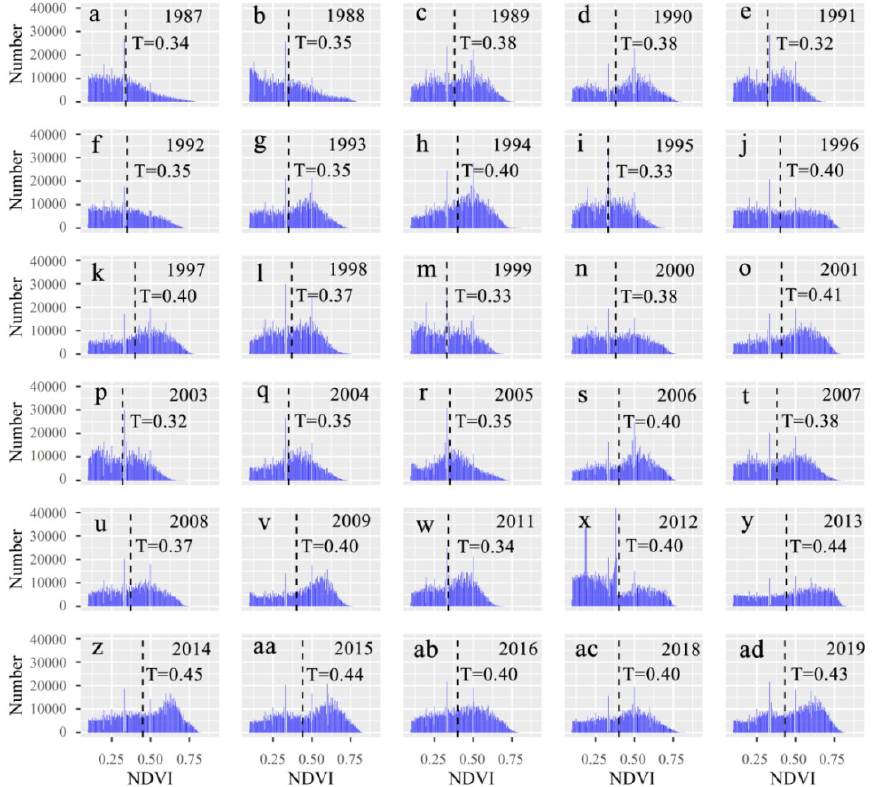
Figure 3. The annual Otsu NDVI threshold of Gongga Mountain from 1987–2019; ( a ) 1987; ( b ) 1988; ( c ) 1989; ( d ) 1990; ( e ) 1991; ( f ) 1992; ( g ) 1993; ( h ) 1994; ( i ) 1995; ( j ) 1996; ( k ) 1997; ( l ) 1998; ( m ) 1999;